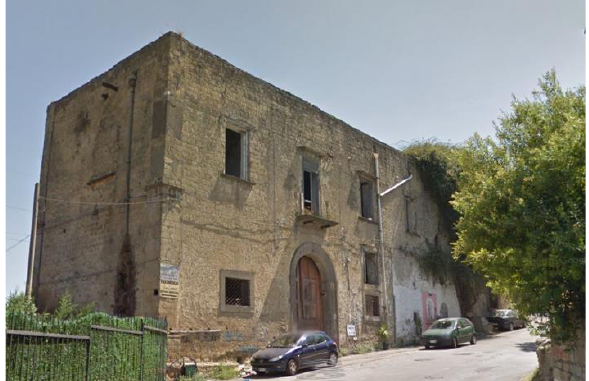
Figure 7. Masseria San Lorenzo, Pianura (NA) Access to the building takes place on via San Lorenzo through the large piperno portal on the left side of the north-west elevation. The portal leads, through two rooms covered by vaults made of lapillus and tuff, called lamie , to the internal courtyard and the main block, consisting of two overlapping orders of arches, leading, on the ground floor, to the service areas and the stables and, on the upper floor, to the living quarters, creating a porch covered by the characteristic dome vaults made up of clay elements, called carusielli or mummarelle (Rutigliano, 1996), Figure 6. Carta Topografica Rizzi – Zannoni, 1794 Location of arranged in concentric circles (Figure 8). three Jesuit farmhouses in Pianura